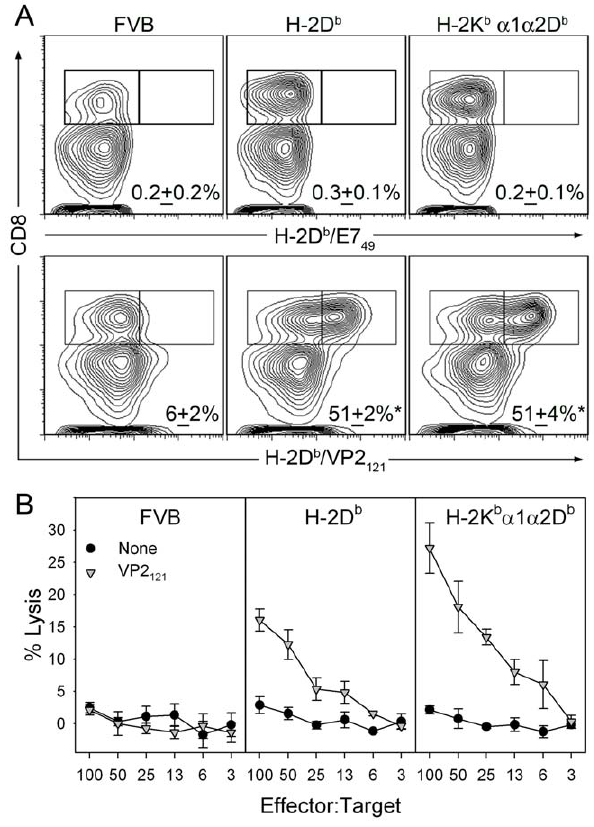
Figure 3. FVB K b a 1 a 2D b transgenic mice generate functional CTL responses against the immunodominant VP2 121–130 pep- tide. (A) Control H-2D b /E7 49–57 and TMEV specific H-2D b /VP2 121–130 tetramer and CD8 staining of acute CD45 + lymphocytes isolated from the brains of transgenic and non-transgenic mice infected with TMEV for 6 days (* p , 0.05 by ANOVA). (B) VP2 121–130 specific killing of peptide pulsed targets by acute brain infiltrating lymphocytes isolated from H- 2D b and H-2K b a 1 a 2D b transgenic mice compared to killing of non- pulsed EL-4 cells.